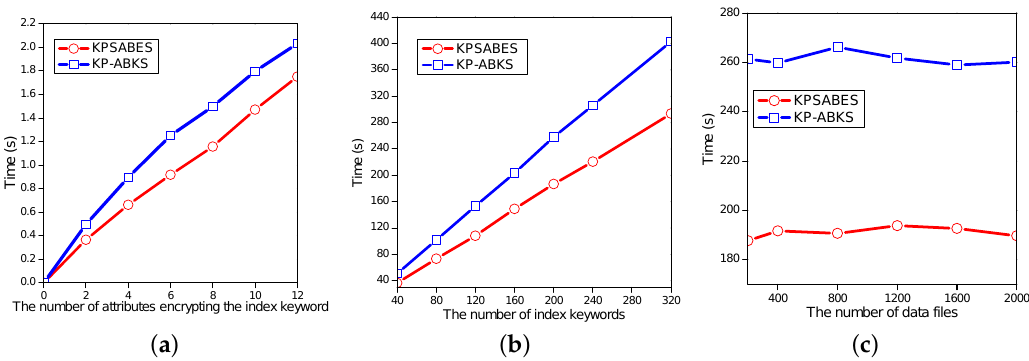
Figure 5. Time cost of Enc algorithm in KPSABES and KP-ABKS: ( a ) time cost of encrypting one index keyword for different number of attributes: ( b ) time cost of encrypting index keywords for different number of index keywords with fixed number of attributes | A | = 6 and fixed number of data files, n = 2000; and ( c ) time cost of encrypting index keywords for different number of data files with fixed number of attributes | A | = 6 and fixed number of index keyword, i = 200.